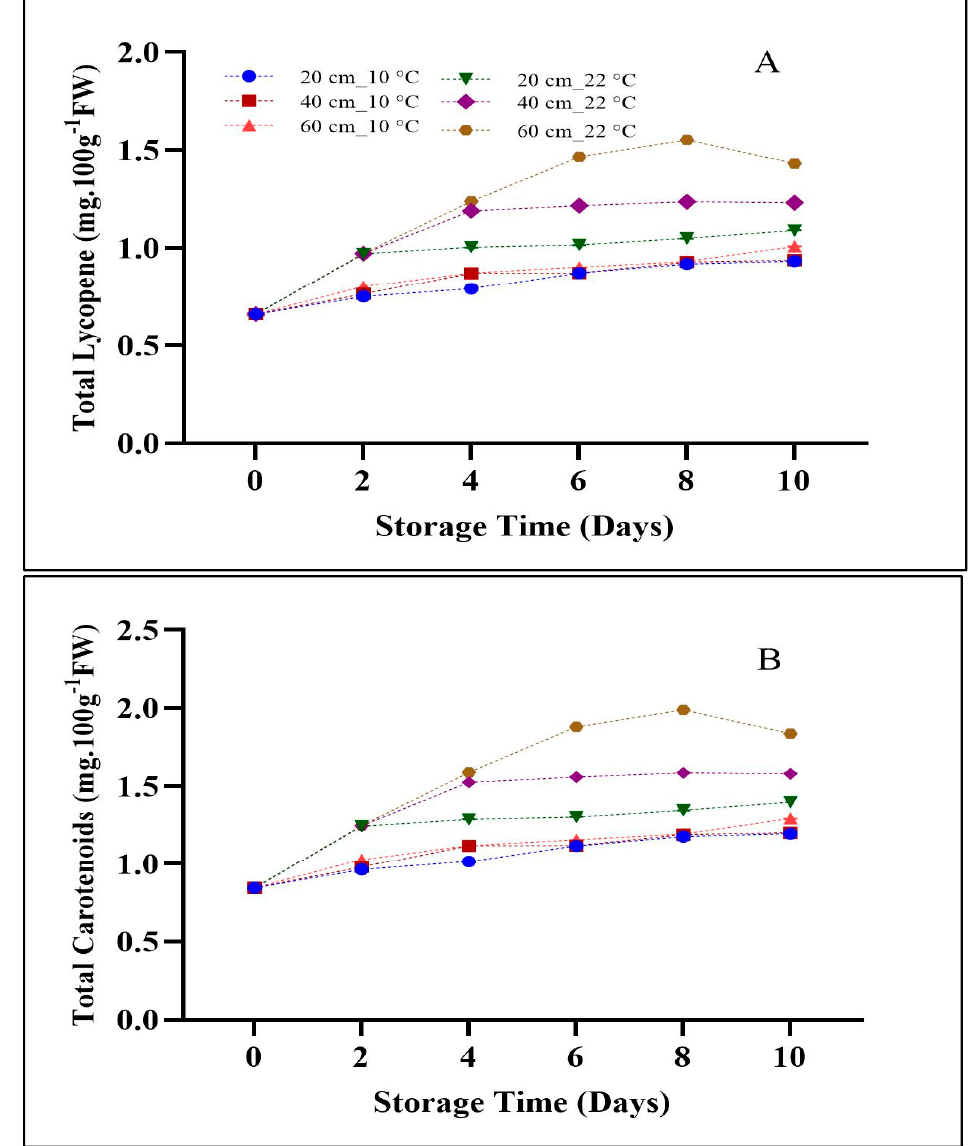
Figure 12. ( A ) Lycopene and ( B ) carotenoid contents of tomato impacted at different drop heights (20 cm, 40 cm, and 60 cm) and stored for 10 days at 10 °C and 22 °C storage conditions. Error bars represent the standard deviation (SD) of the mean values ± S.D. of six readings of three replicates.